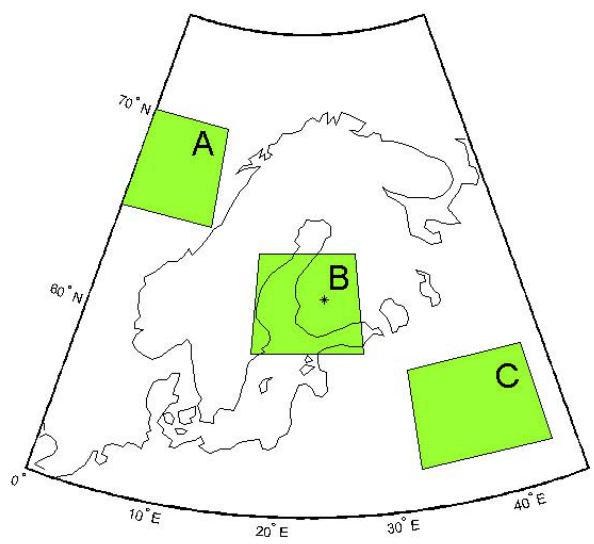
Fig. 2. Three sectors were selected to study concentration trends. Sector A represents marine environment, sector B the vicinity of Hyyti¨al¨a measurement station and sector C continental environ- ment.